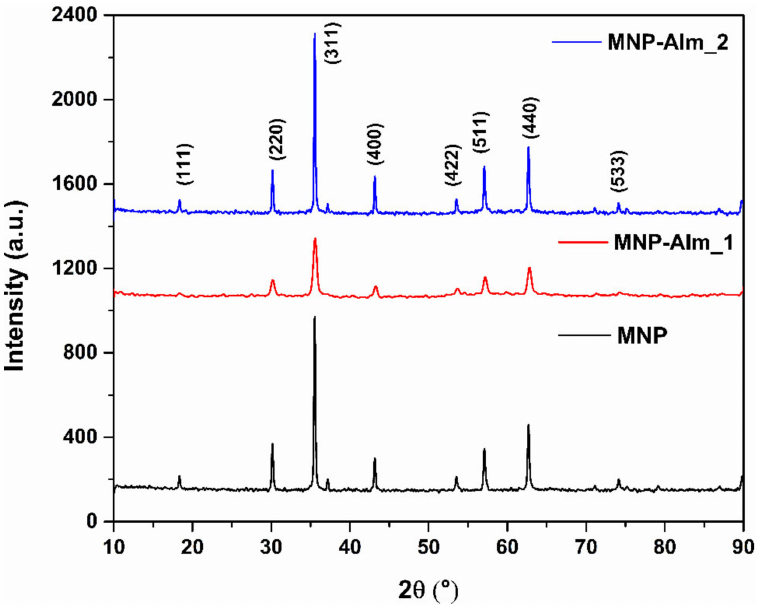
Figure 3. X -ray diffraction (XRD) patterns of magnetic nanoparticles MNP, MNP-AIm_1, and MNP- AIm_2.